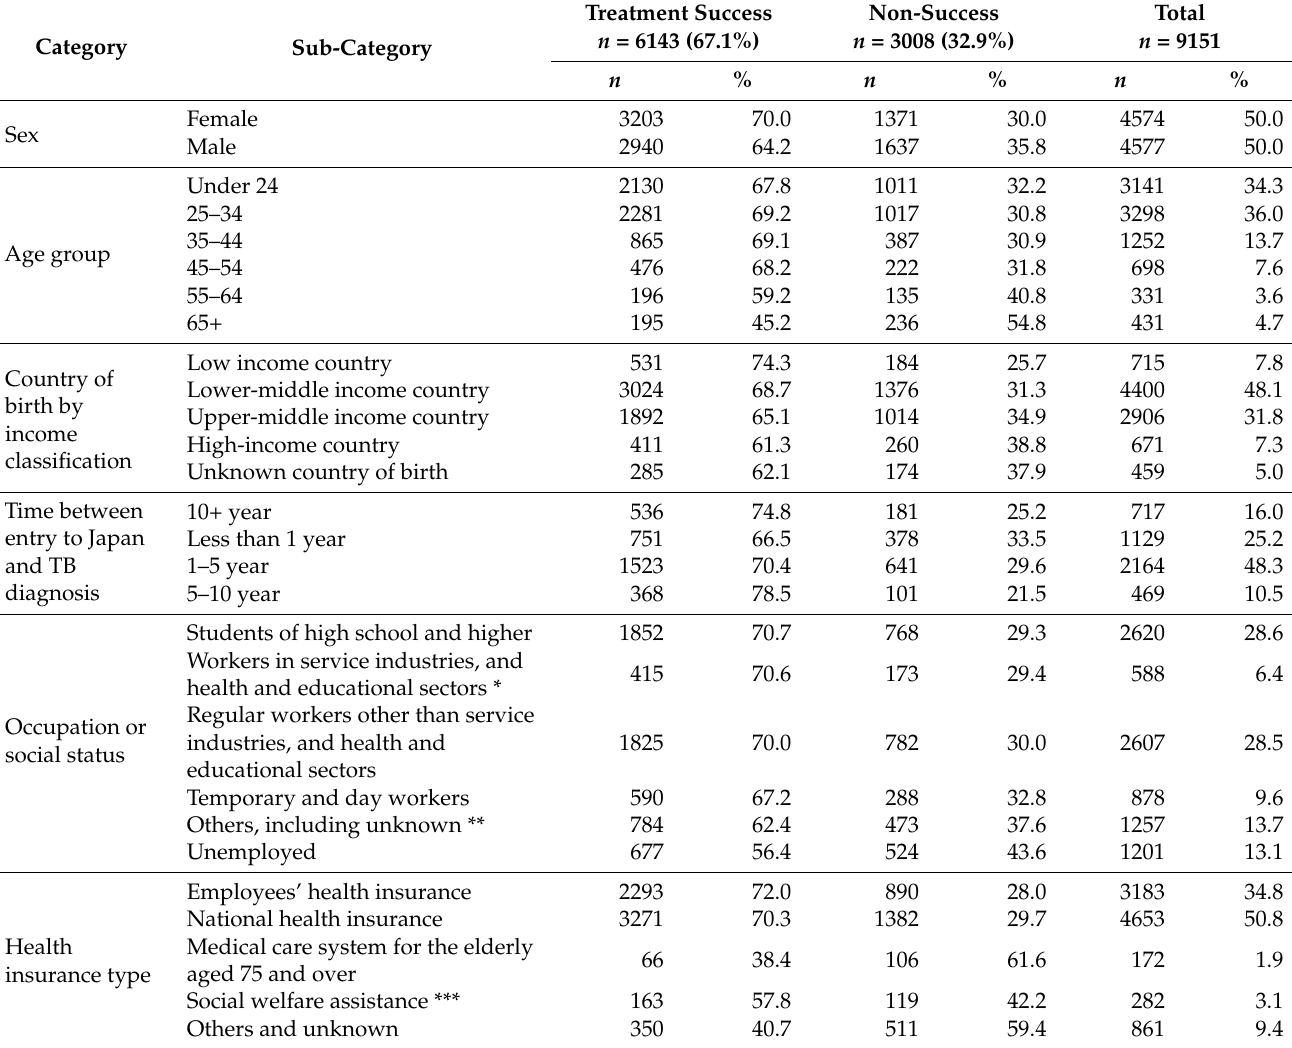
Table 1. Characteristics of overseas-born patients with pulmonary tuberculosis in 2009–2018, by treatment